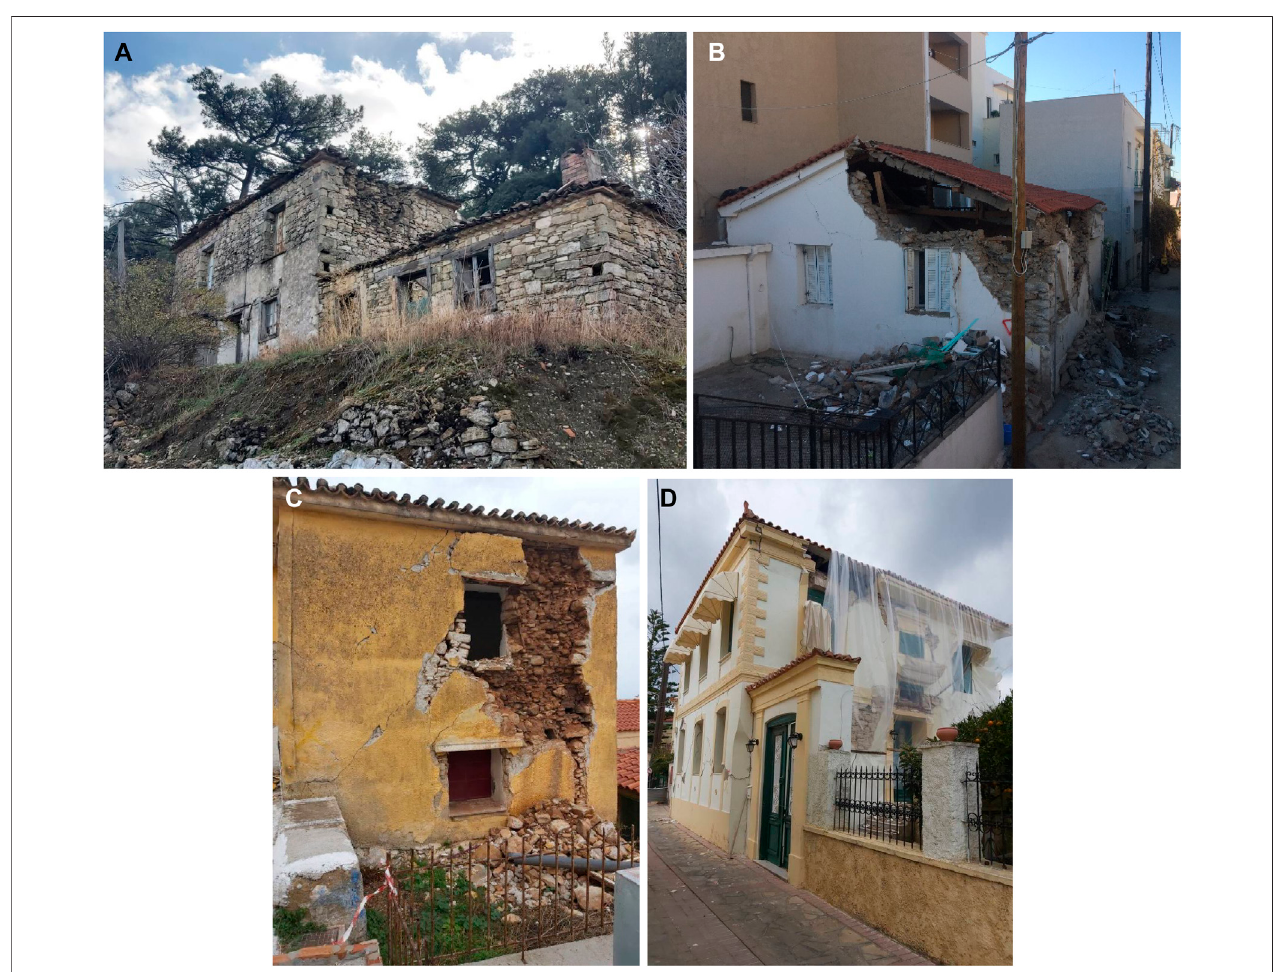
FIGURE5| Examplesofout-of-planefailureinmasonrystructures: (A) Partialoverturningoftheexternalleaf; (B) Cornerfailureandpartialoverturningofgable; (C) : Out-of-plane failure of the external lead of a multi-leaf masonry wall with mud mortar; (D) Out-of-plane failure of a brick wall) [DG3-DG5](all in Samos, Greece).